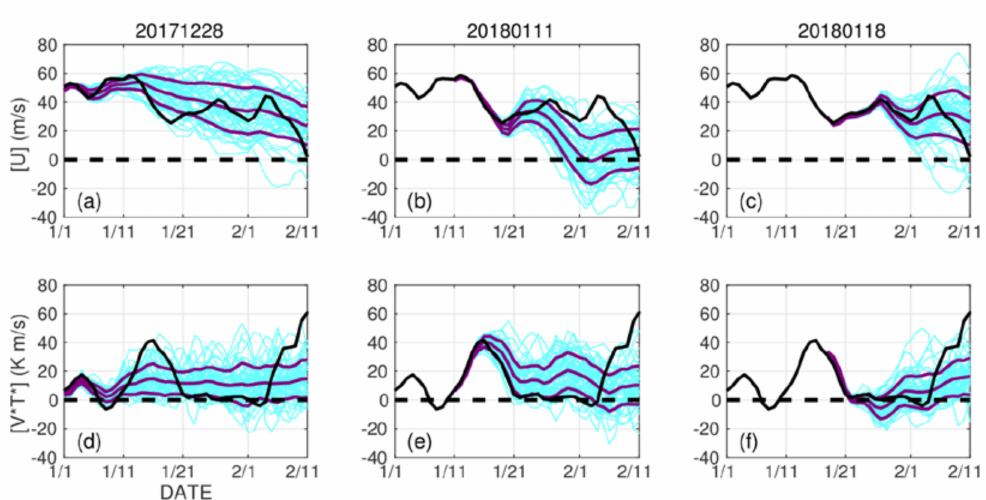
Figure 9. Same as Figure 3, but for the second cluster. Top panels ( a – c ) plot the zonal mean zonal wind, and bottom panels ( d – f ) plot the heat